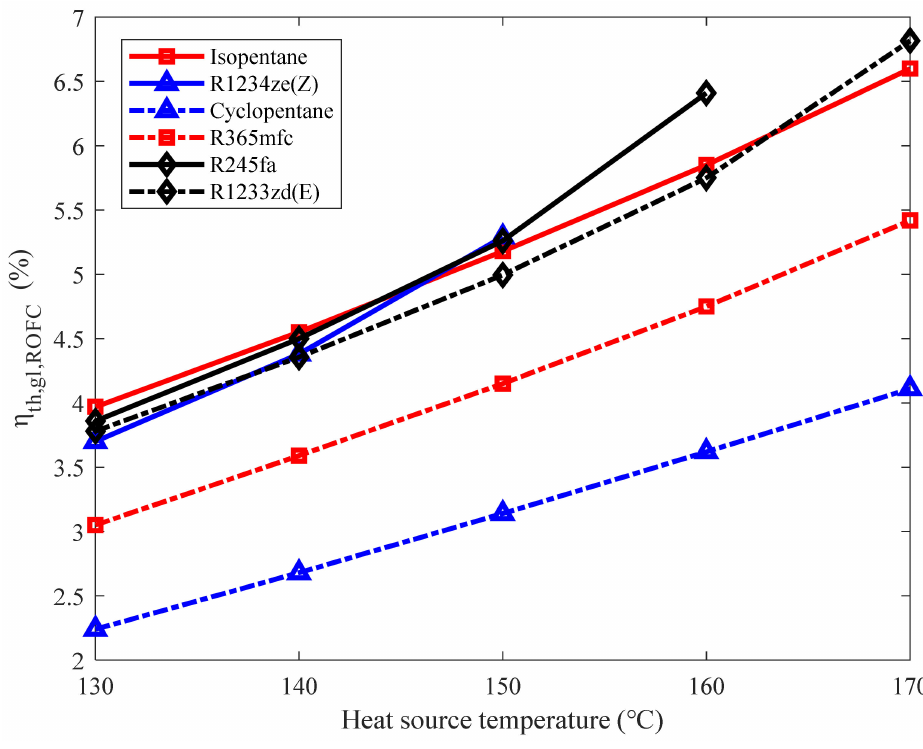
Figure 11. Effect of heat source temperature on global thermal